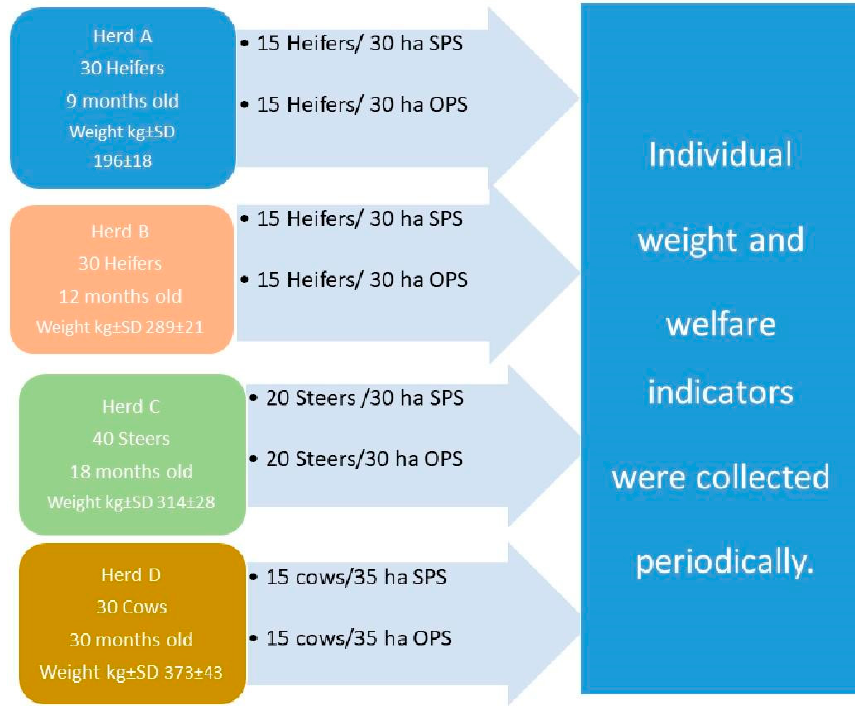
Figure 1. Main characteristics of the research design. Mean weight ± SD (SD: standard deviation) are given in kilograms. SPS, silvopastoral systems, OPS, open pasture systems. Note: Once assigned to each plot, animals were maintained there for the entire study period, and all animals were individually identified. A total of 130 animals were studied.